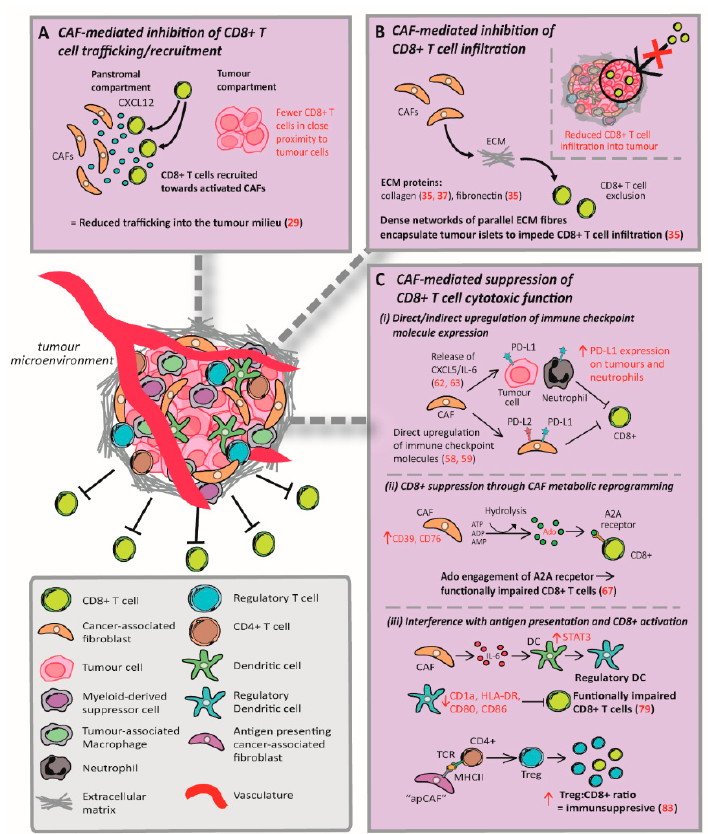
Figure 1. Mechanisms of cancer-associated fibroblast inhibition of CD8 + cytotoxic T cells. CAFs mediate inhibition of CD8 + T cells through interference with ( A ) T cell-tra ffi cking / recruitment, ( B ) infiltration, and ( C ) cytotoxic function. Figure compiled from the following sources: